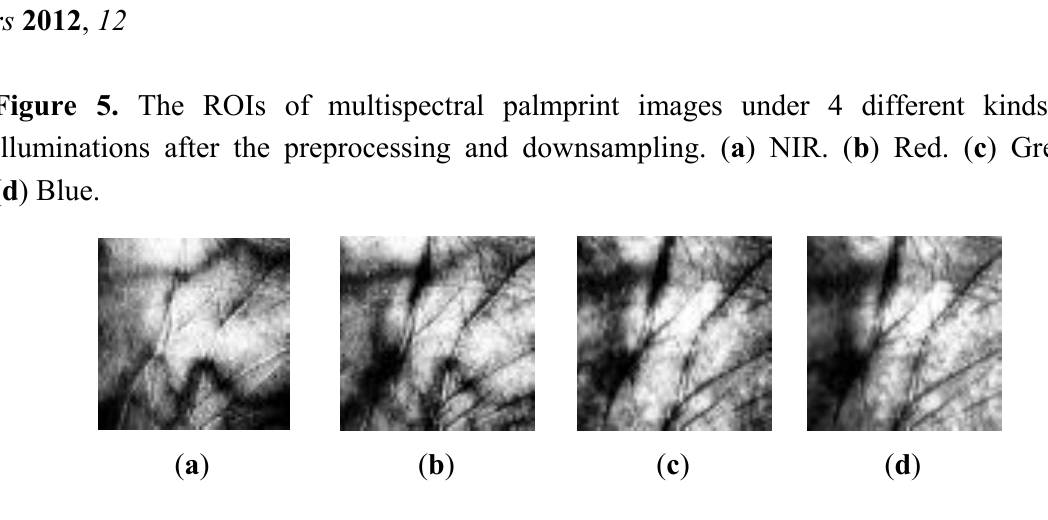
Figure 6. A quaternion vector sample built using the input image in Figure